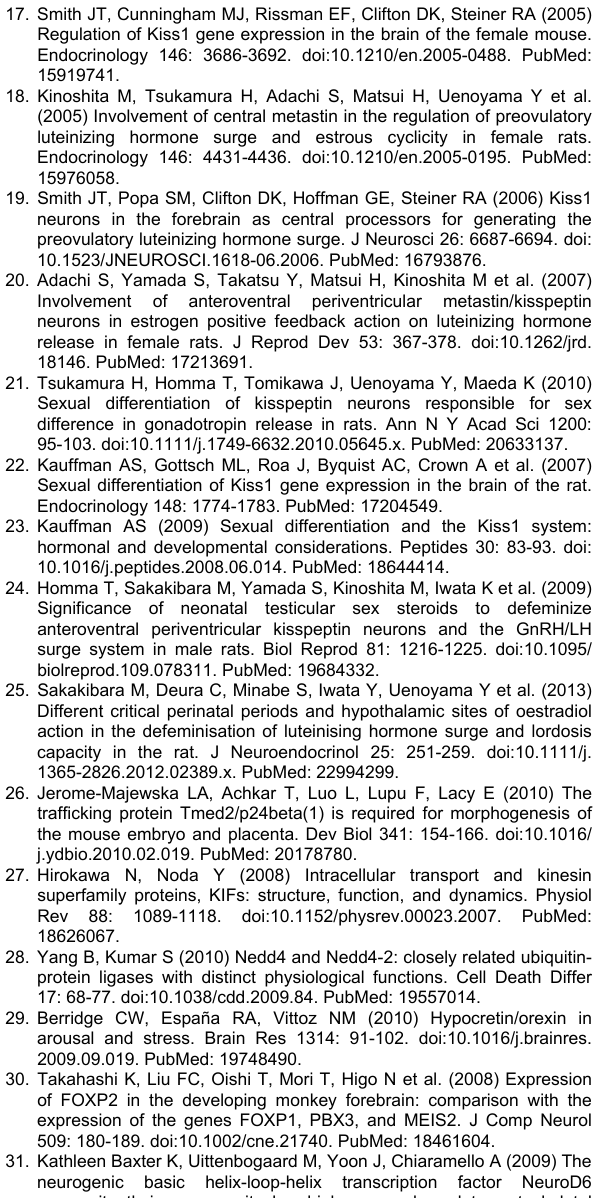
Table S1. Sequence of primers used for